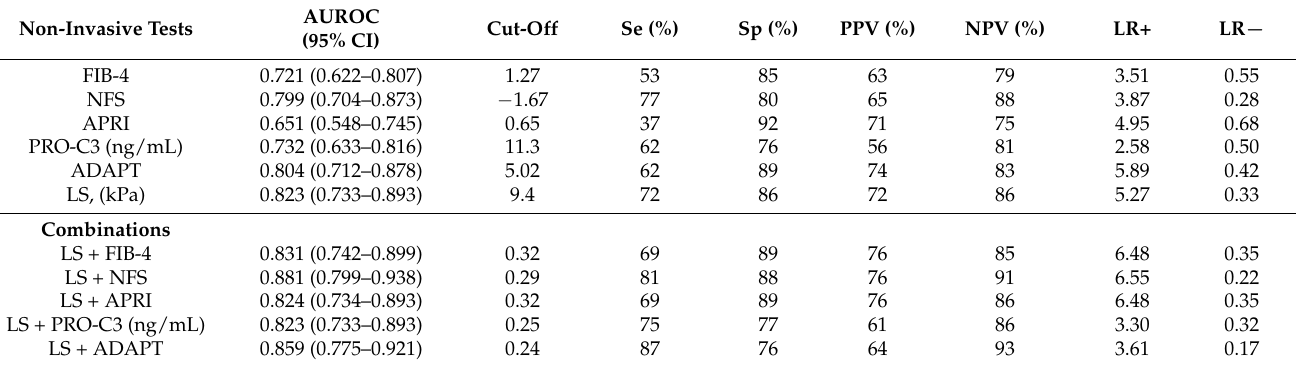
Table 3. Diagnostic accuracy of FIB-4, NFS, APRI, PRO-C3, and ADAPT, alone or in combination with liver stiffness for the identification of advanced